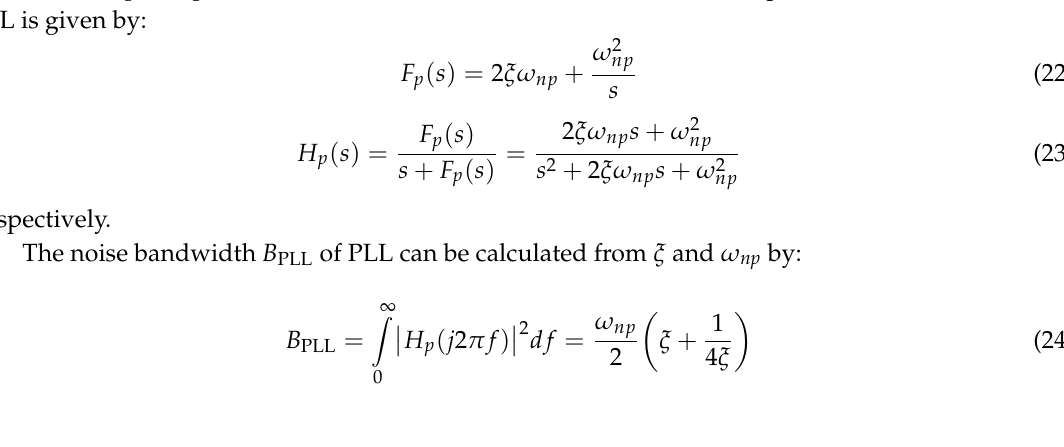
Figure 11. Block diagram of the PLL in S-domain.